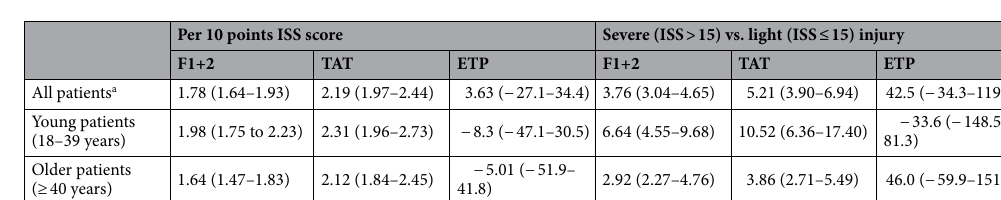
Figure 2. Prothrombin fragment F1+2 (F1+2), thrombin-antithrombin (TAT) complexes, and endogenous thrombin potential (ETP) on admission to hospital (0 h) and after 15 and 72 h hospital stay. ( A ) and ( B ): F1+2 levels were above the age-dependent reference intervals in 55% (95% CI 47–62%) of the young and 74% (95% CI 68–80%) of the older patients on admission. Compared with admission levels, relative F1+2 levels 15 and 72 h after the admission were 1.08 (95% CI 0.50–1.67,) and 0.49 (95% CI 0.32–0.66) among the young and 0.95 (95% CI 0.33–1.58) and 1.23 (95% CI − 0.22–2.68) in the older patients. 2.3% (95% CI 0.1–4.6) of the young and 1.2% (95% CI 0.2–2.7%) of the old presented with levels below the reference interval. ( C ) and ( D ): TAT complex levels on admission were above the age-dependent reference intervals in 79% (95% CI 73–85%) of the young and 91% (95% CI 88–95%) of the older patients. Compared with admission levels, relative TAT complex levels 15 and 72 h after the admission were 0.73 (95% CI 0.42–1.05) and 0.26 (95% CI 0.15–0.38) in the young and 1.11 (95% CI 0.30–1.93) and 0.36 (95% CI 0.14–0.58) in the older patients. ( E ) and ( F ): The ETP on admission was above the age-dependent reference interval in 7.0% (95% CI 3.2–10.8%) of the young and 15.5% (95% CI 10.9–20.1) of the older patients. None of the younger patients presented with an ETP below the reference interval while this occurred in 7.6% (95% CI 4.2–10.9) of the older patients. Relative to admission levels, the ETP at 15 and 72 h were 0.92% (95% CI 88.4–95.5) and 0.99% (95% CI 0.93–1.04) in the younger patients and 0.93% (95% CI 0.89–0.96) and 0.99 (95% CI 0.92–1.06) in the older patients. Boxes are median with interquartile range and whiskers are 2.5 and 97.5% percentils. Thick horizontal lines indicate age-dependent reference intervals for each parameter.